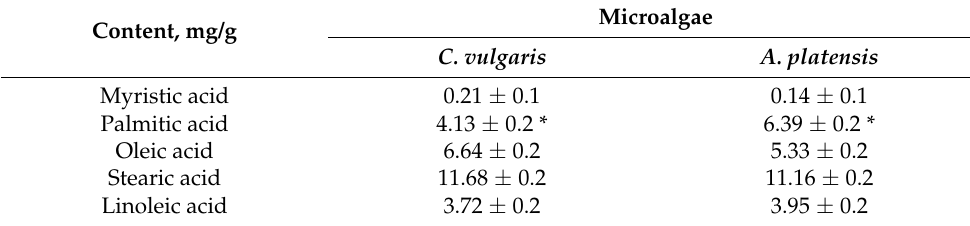
Table 3. Fatty acid composition of the lipid fraction of the lipid complex of microalgae samples.